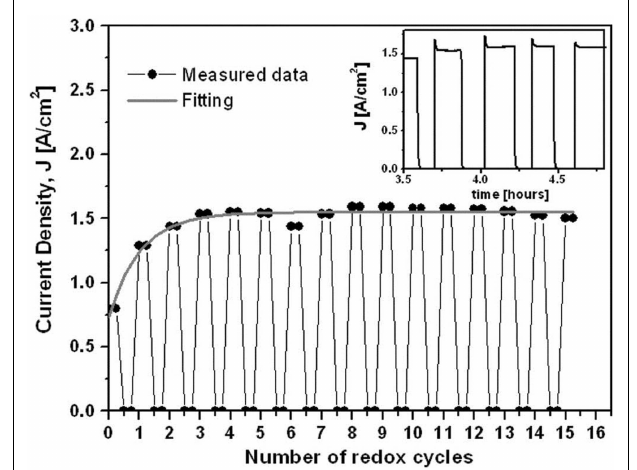
FIGURE 4 | Maximum cumulative redox strain (CRSmax) values obtained in isothermal redox cycling dilatometry comprising three redox cycles, as a function of estimated total porosity of different Ni–YSZ cermets (Pihlatie et al., 2009) . Reprinted with permission from Elsevier.